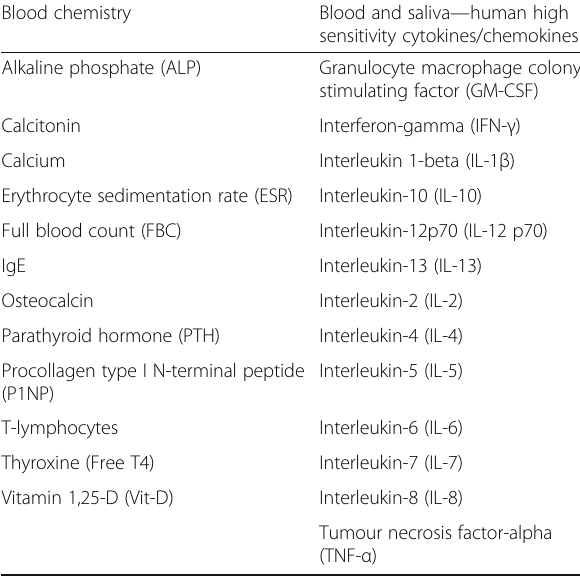
Table 1 Biomarkers tested in patients with moderate to severe